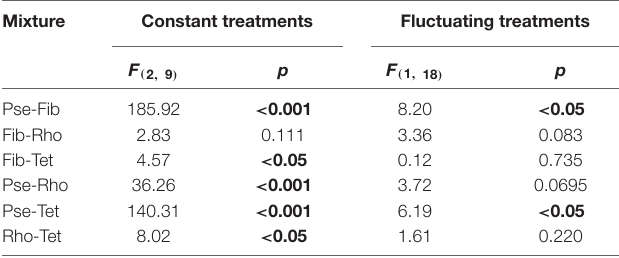
TABLE 5 | ANOVA outcomes ( F and p -values given) testing for effects of constant and fluctuating light on the relative proportion of species in the two-species